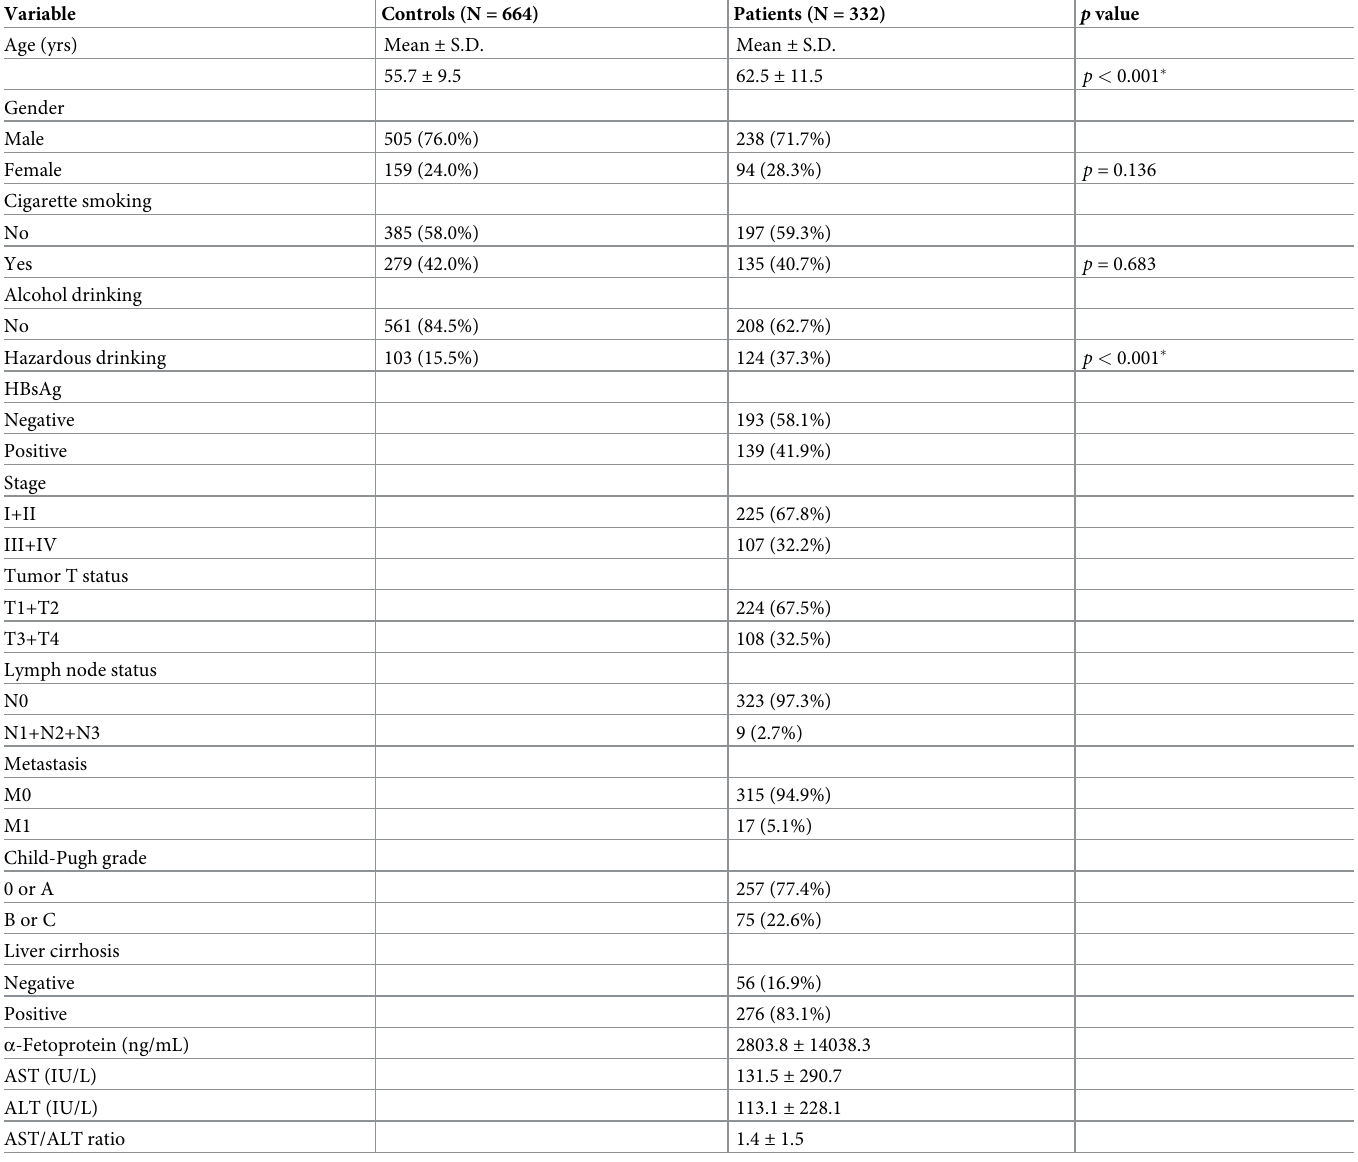
Table 1. The distributions of demographical characteristics in 664 controls and 332 patients with